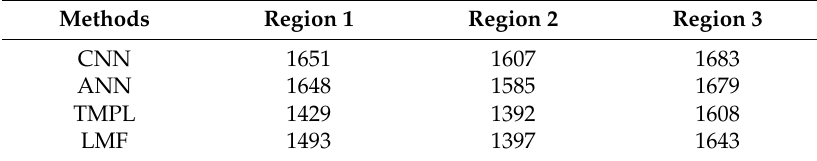
Table 5. Summary of the number of correctly detected palm trees for all four methods.